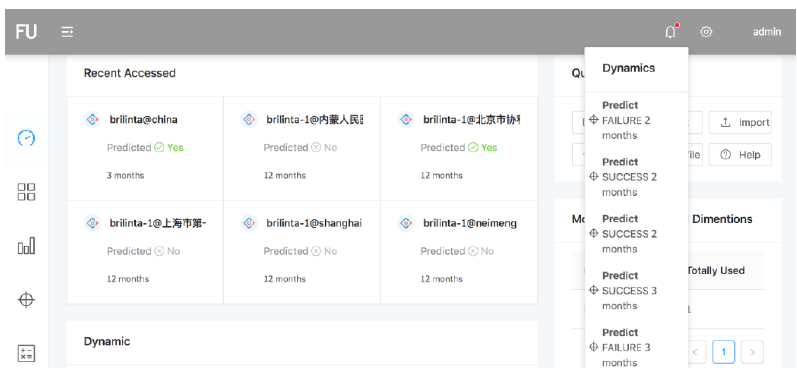
Figure A2. Main page of the sales data prediction and analysis decision system. If we click the “bell” sign, it will show the status (success or failure) of the sales prediction for any sales prediction task.